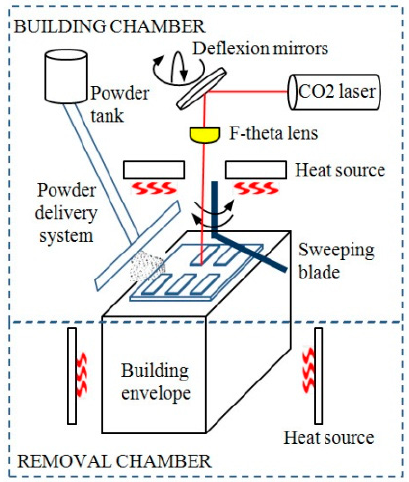
Figure 1. Structure of EOS Formiga P100 selective laser sintering (SLS) machine.